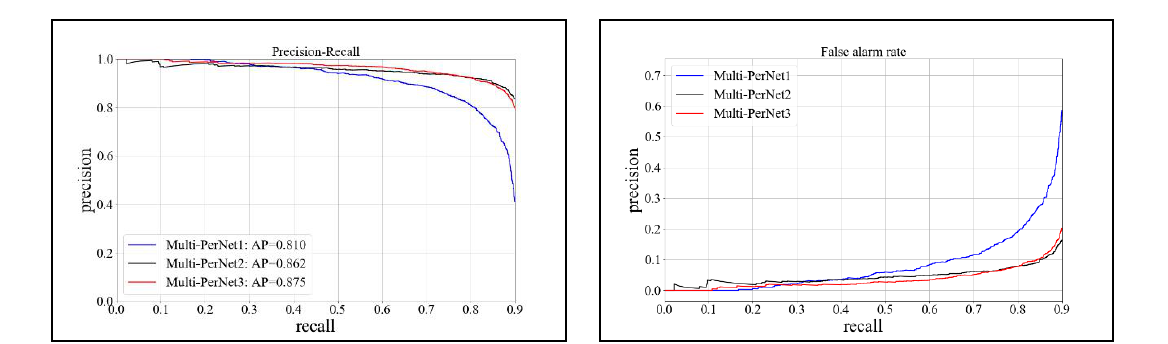
Table 2. Introduction of experimental data.